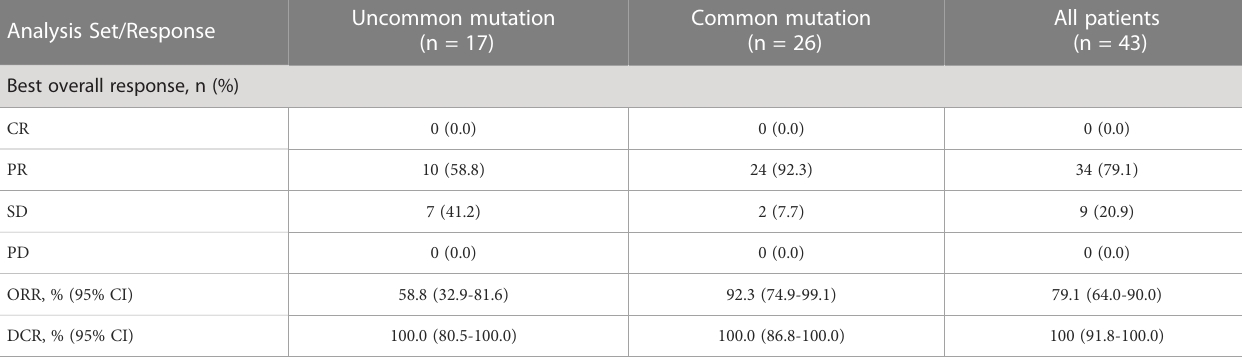
TABLE 4 Systemic activity of afatinib in patients with brain